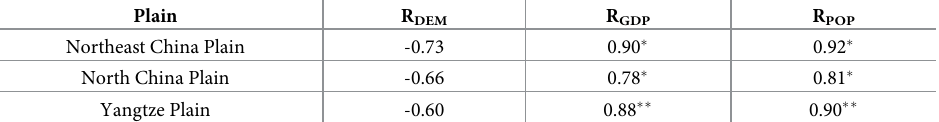
� indicated the value was significant at the 0.05 level